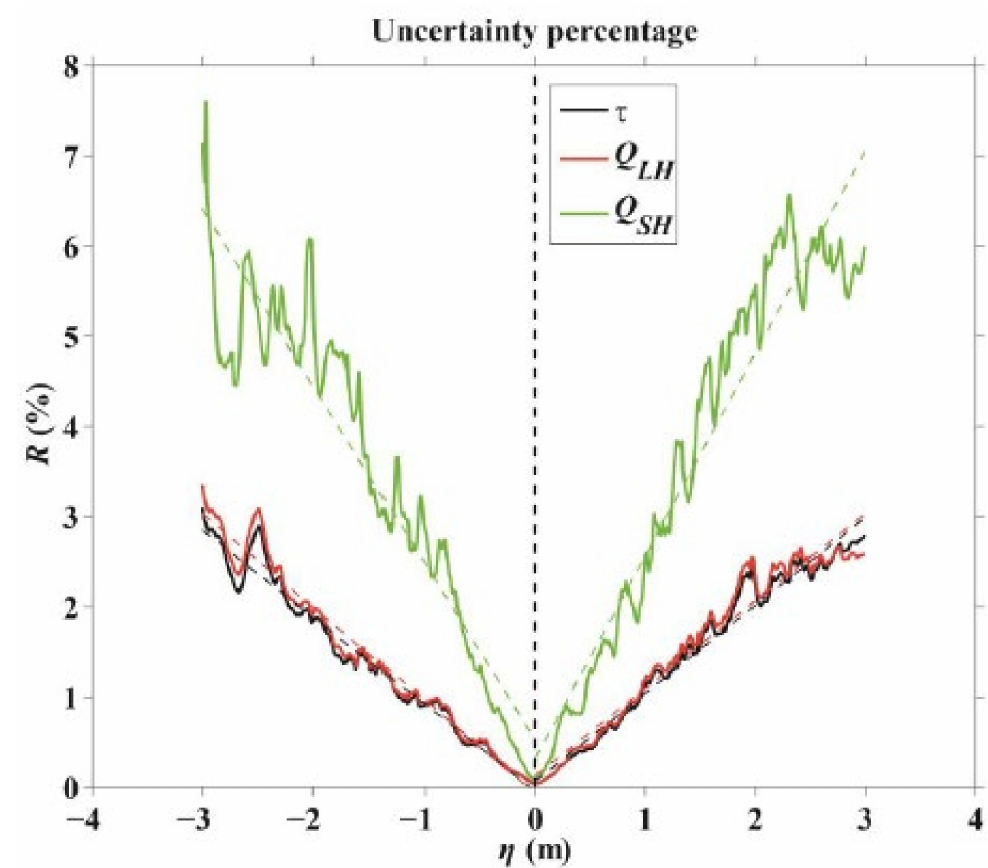
Figure 8. The uncertainty percentages ( R ) of wind stress (solid green), latent heat flux (solid red), and sensible heat flux (solid black) with variations in SSE ( η ) ranging from − 3 to 3 m. The linear trends are incorporated with dashed